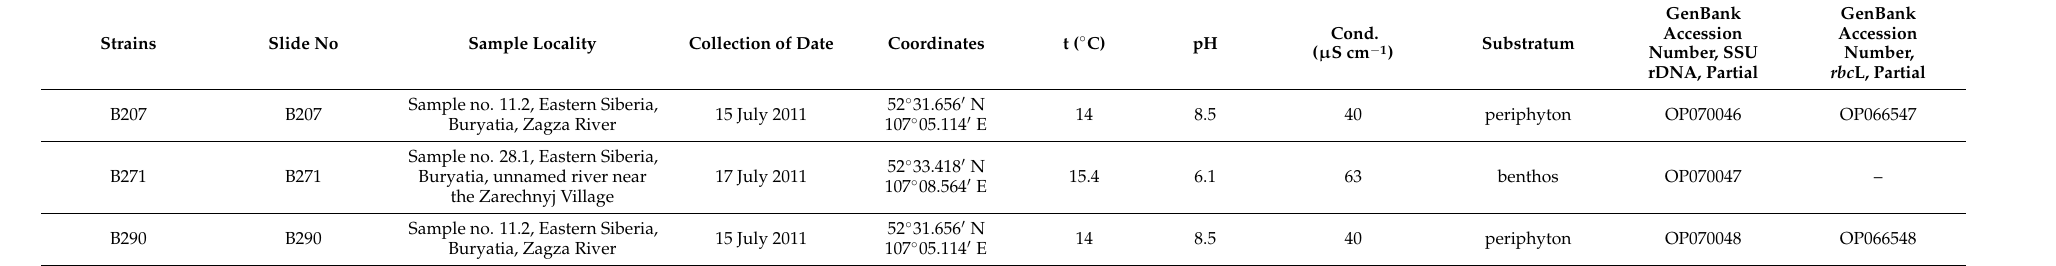
Table 2. List of all strains examined in this study with their GenBank accession